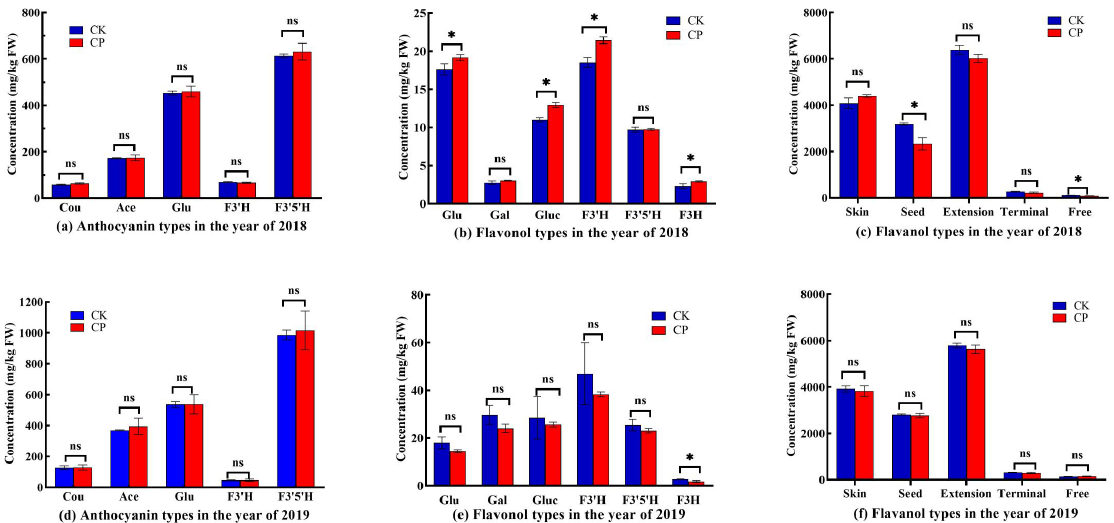
Figure 4. Effect of covering purslane on different flavonoid concentrations of grape berries. Glu, glucoside from anthocyanins or flavonols; Ace, acetylated anthocyanins; Cou, coumarylated anthocyanins; Gal, galactosidic flavonols; Gluc, glicironide form flavonols; F3′H, 3′-hydroxylated anthocyanins or flavonols; F3′5′H, 3′5′-hydroxylated anthocyanins or flavonols; F3H, 3-hydroxylated flavonols; Free, free monomers. * indicates significant differences between the control and covering purslane ( p < 0.05, t -test), ns, not significant.